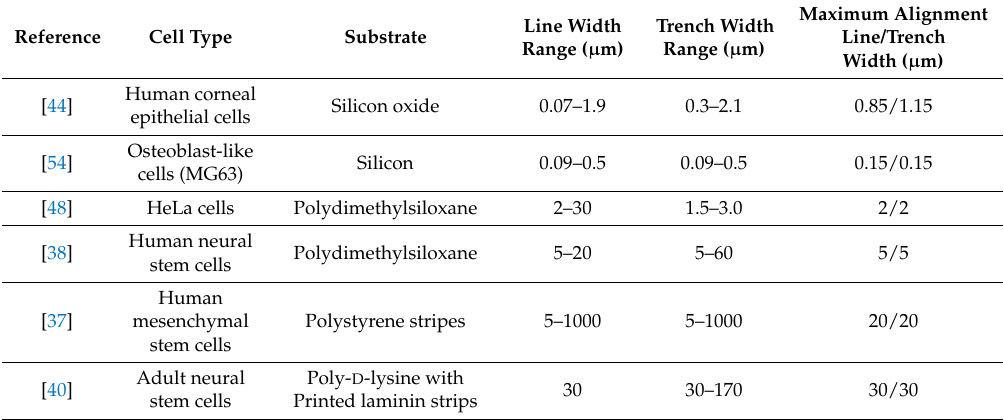
Results of cell alignment performance on various substrate materials and surface pattern